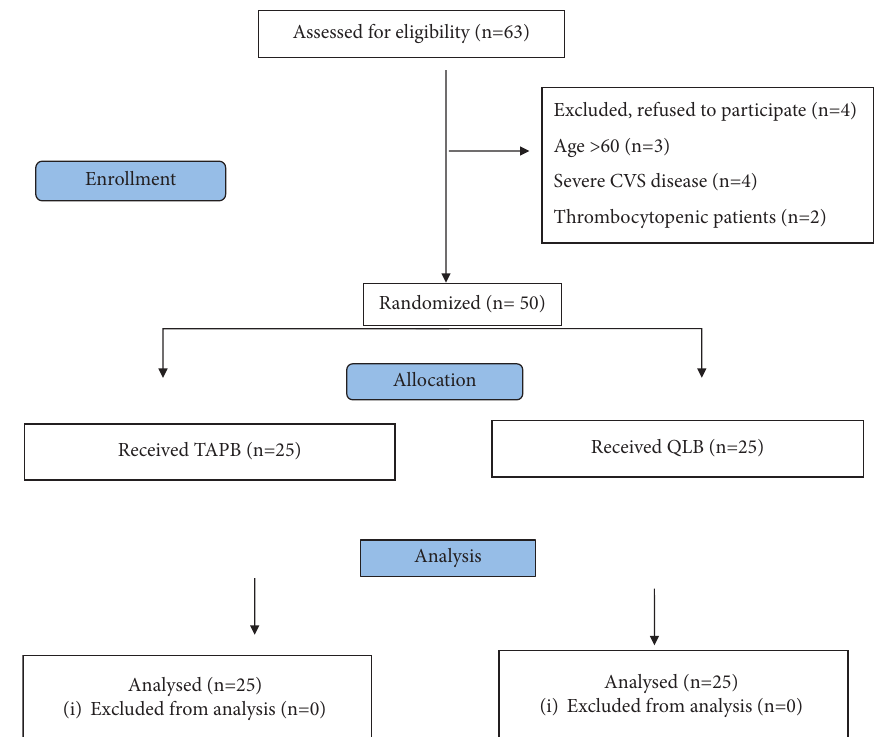
Figure 1: Consort flow diagram of the study population. n , number; TAPB, transversus abdominis plane block; QLB, quadratus lumborum block.